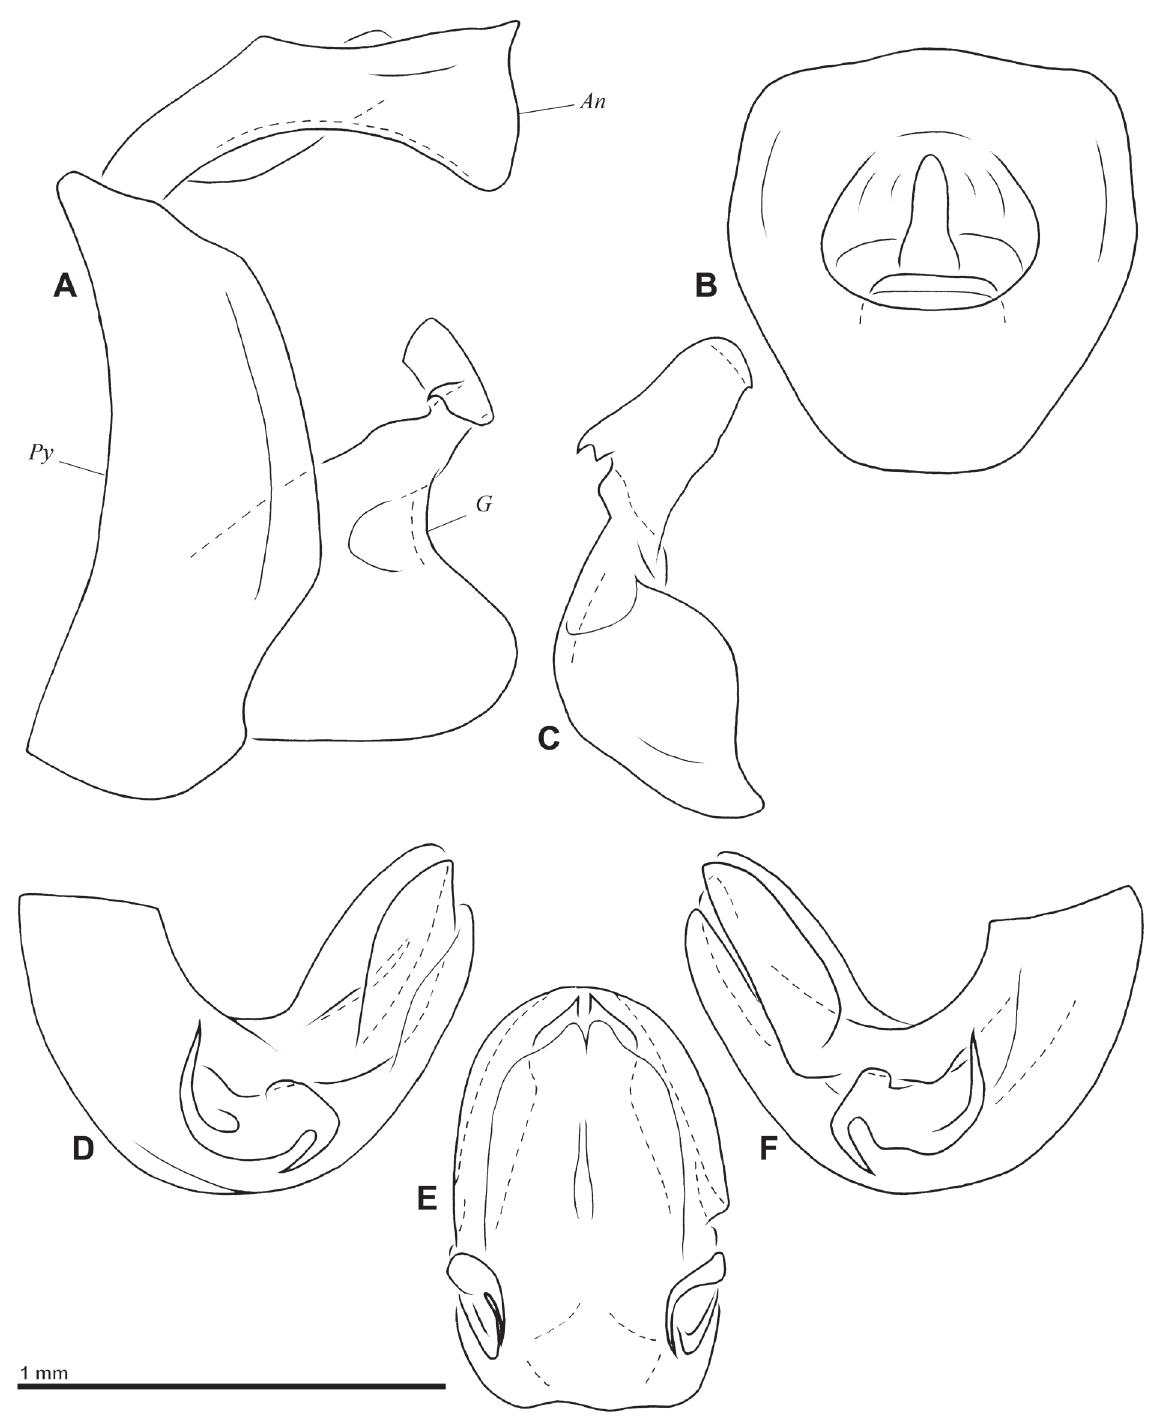
Fig. 4. Gergithoides nui sp. nov., ♂, genitalia. A . Pygofer, anal tube and gonostylus, left lateral view. B . Anal tube, dorsal view. C . Left gonostylus, posterior view. D . Aedeagus, left lateral view. E . Aedeagus, posteroventral view. F . Aedeagus, right lateral view. Abbreviations: An = anal tube; G = gonostylus; Py =